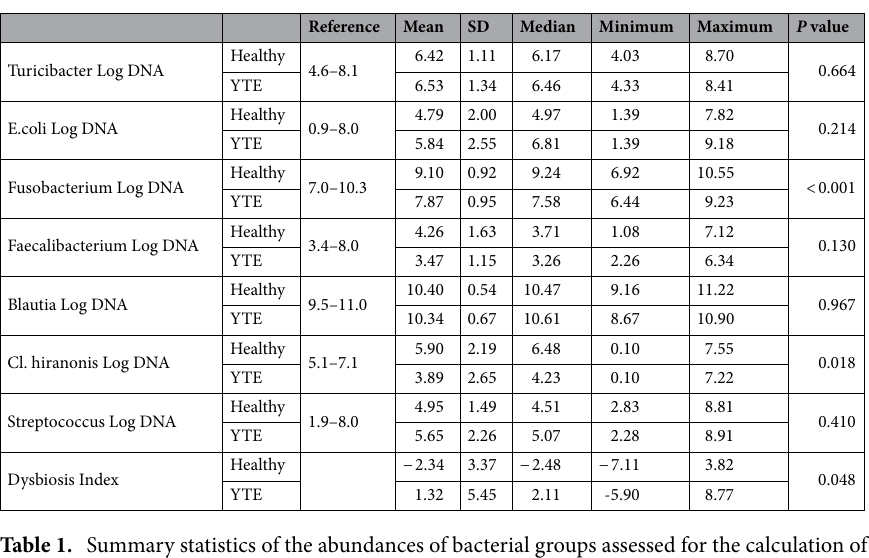
Table 1. Summary statistics of the abundances of bacterial groups assessed for the calculation of the DI in healthy and YTE dogs. DI, dysbiosis index, YTE, Yorkshire Terrier enteropathy; SD, standard deviation.